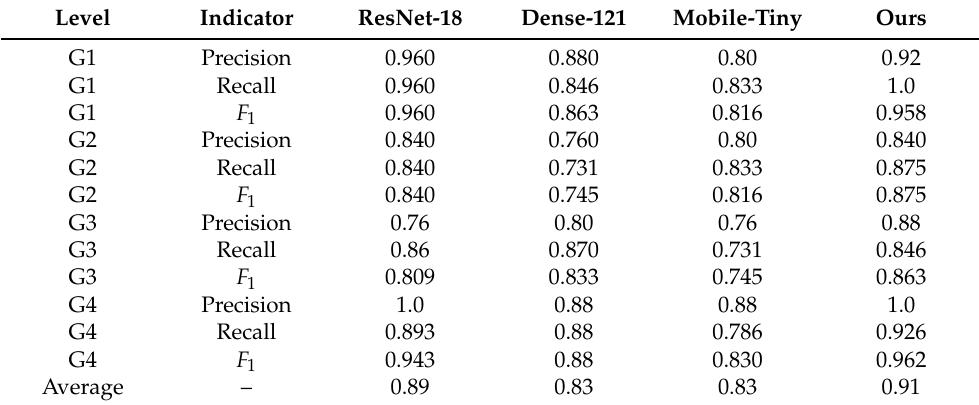
Table 3. The evaluation results of four comparison models on each maturity